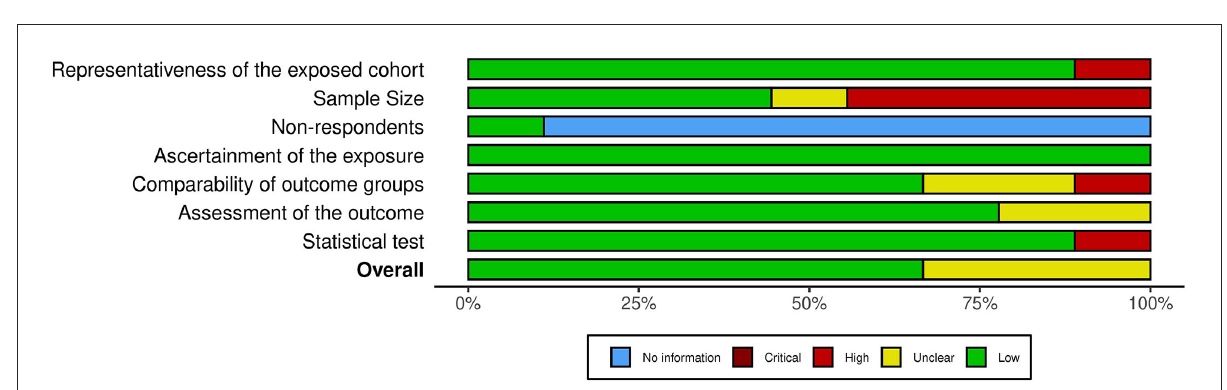
FIGURE3 Forest plot showing the prevalence of depression among patients with enterostomy in the included